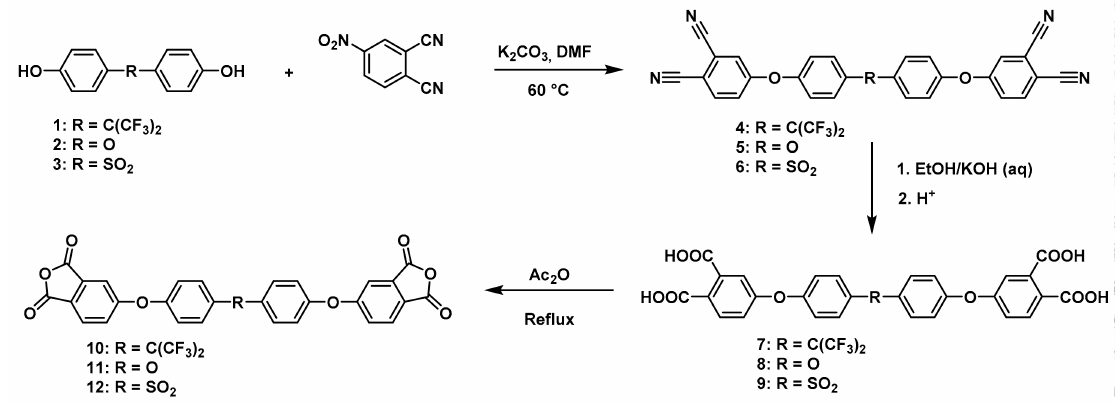
Figure 1. Synthetic route of precursors ( 4 – 9 ) and tetracarboxylic dianhydride monomers ( 10 – 12